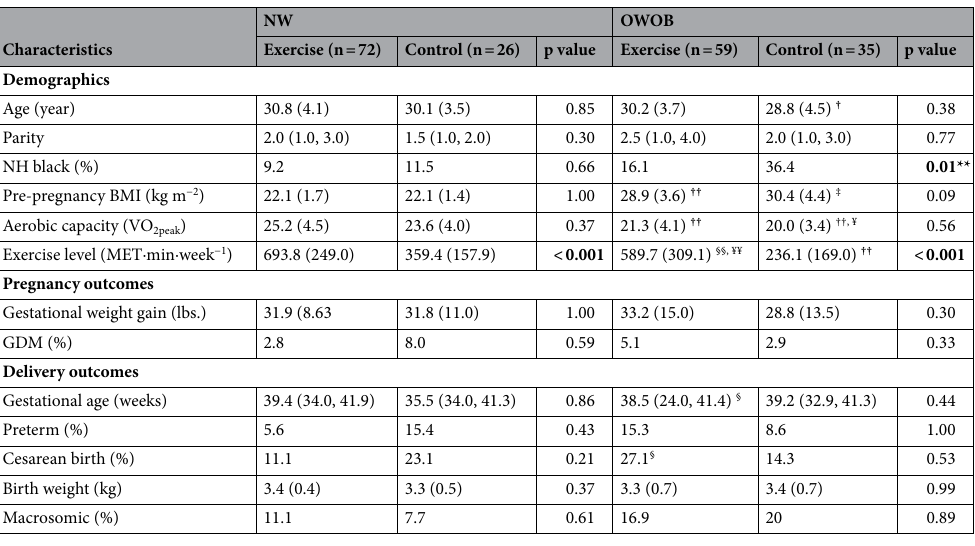
Table 2. Intention to treat analysis of maternal descriptive, pregnancy and delivery outcomes by Intervention and BMI Group. Means (SD), medians (range) and proportions are reported and Student’s t-test, Wilcoxon Rank Sum tests and Fisher’s Exact tests were performed, respectively. NH non-Hispanic. Within BMI class comparison *p < 0.05, **p < 0.01, p < 0.001; §§ p = 0.06 relative to NW Exercise group; § p < 0.05 relative to NW Exercise group; † p = 0.01 relative to NW Exercise group; †† p < 0.001 relative to NW Exercise group. ‡ p < 0.001 within BMI and between NW BMI groups; ¥ p < 0.01 relative to NW Control group; ¥¥ p < 0.001 relative to NW Control group. Significant values are in